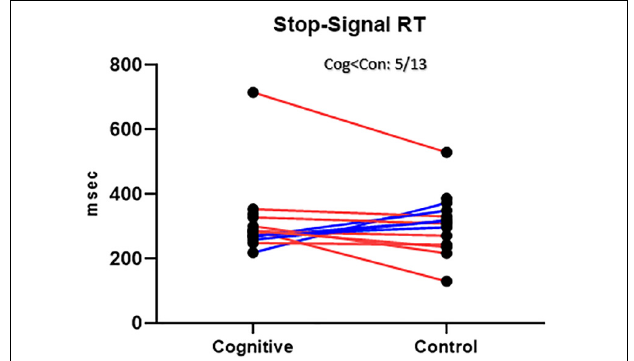
FIGURE 10 | SST Results, MPH-Cognitive induction condition vs. MPH-Control induction condition. Stop-Signal Response Time (SSRT), per -participant, per -condition. There was no significant average difference between conditions in the SSRT. Blue lines represent participants who performed better in the MPH-Cognitive condition, while red lines represent participants who performed better in the MPH-control